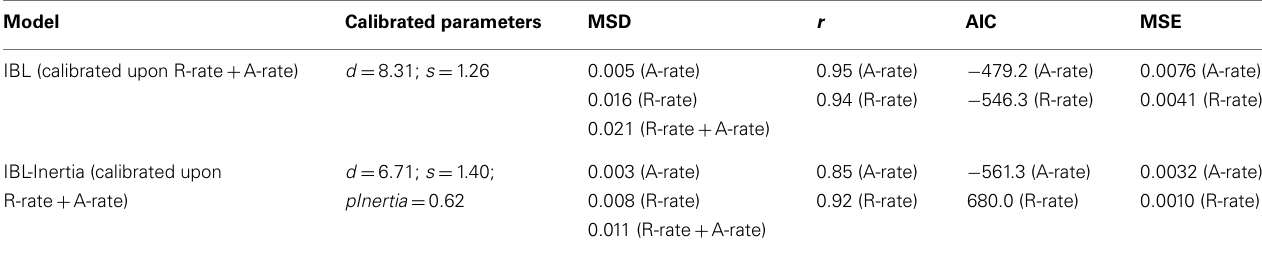
Table 1 |The values of calibrated parameters for IBL and IBL-Inertia models and the MSD, r ,AIC, and MSE inTPT’s estimation set.